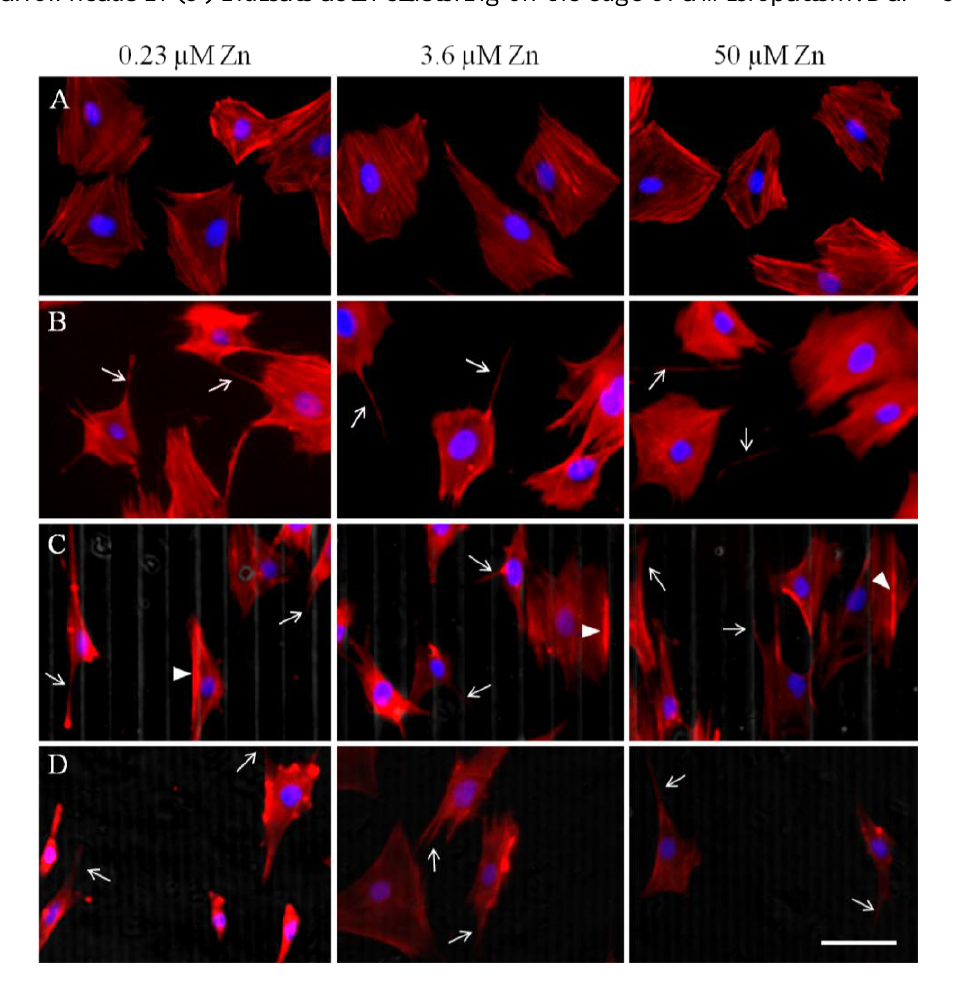
Figure 2. Immunofluorescence micrographs of F-Actin (visualized in the red channel) 24 h after seeding at various zinc concentrations on ( A ) tissue culture polystyrene (TC); ( B ) flat polydimethylsiloxane (PDMS); ( C ) wide PDMS pattern; and ( D ) narrow PDMS pattern. Nuclei are visualized in the blue channel. Arrows indicate discrete lamellipodia protrusions while arrowheads in (C) indicate actin clustering on the edge of a micropattern. Bar = 50